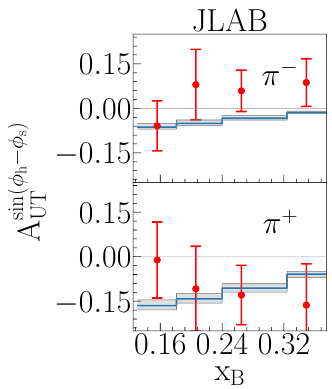
Figure 10 . JLab measurement of the Sivers asymmetry for a neutron target [45] as a function of x B . The central curve as well as the uncertainty band are generated using the result from fit